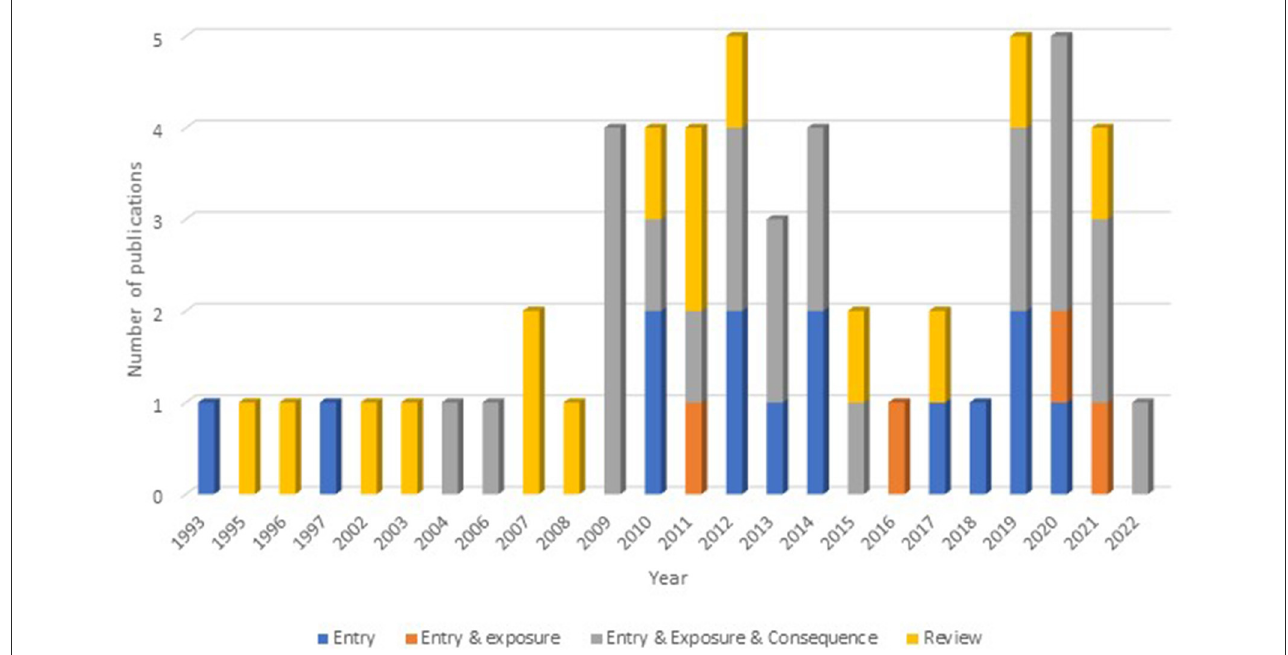
FIGURE2 The number and scope of qualitative risk assessments resulting from the search criteria by